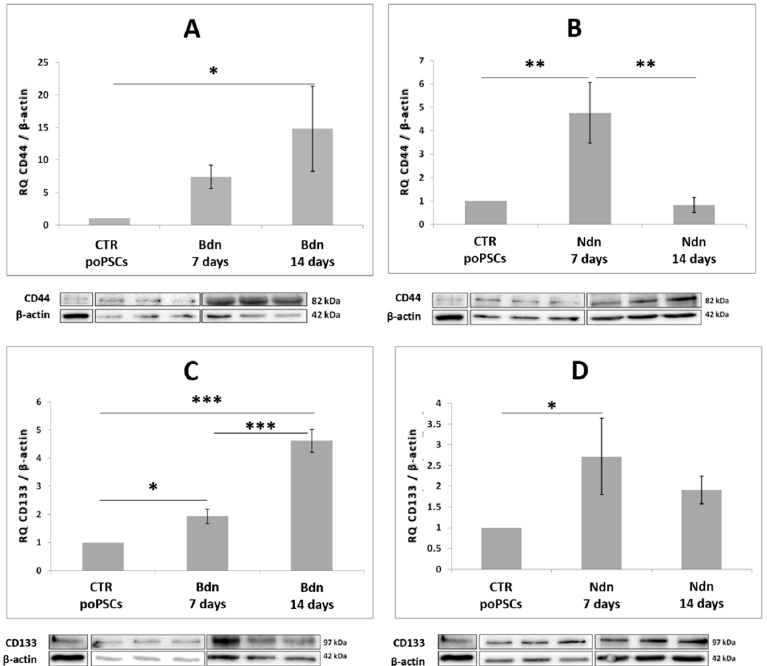
Figure 4. Expression of the protein markers CSCs: CD44 ( A , B ) and CD133 ( C , D ) at the level of total protein on day 7 and 14 of culture in the presence of boldenone ( A , C ) and nandrolone ( B , D ). The graphs show the relative content of CD44 and CD133 proteins obtained from measurements of the optical density of the bands representing a specific signal. Results represent the mean with n = 5 ± standard deviation (SD). Statistical analysis: homogeneity of variance—Levene’s test, normality of distribution—Shapiro–Wilk test, one-way ANOVA, Tukey’s post-hoc test, * p < 0.05; ** p < 0.01; *** p < 0.001.